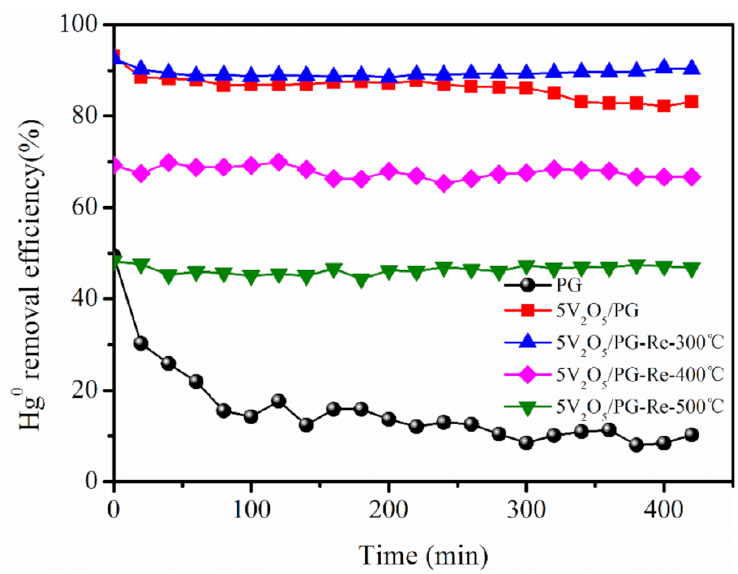
Figure 8. Comparison of Hg 0 removal over PG, 5V 2 O 5 /PG, 5V 2 O 5 /PG-Re-300 ◦ C, 5V 2 O 5 /PG-Re-400 ◦ C, and 5V 2 O 5 /PG-Re-500 ◦ C (reaction condition: O 2 = 8%, H 2 O = 5%, SO 2 = 0.15%, N 2 as balance, C Hg0 = 240 µ g/m 3 , GHSV = 6000 h − 1 , T = 150 ◦